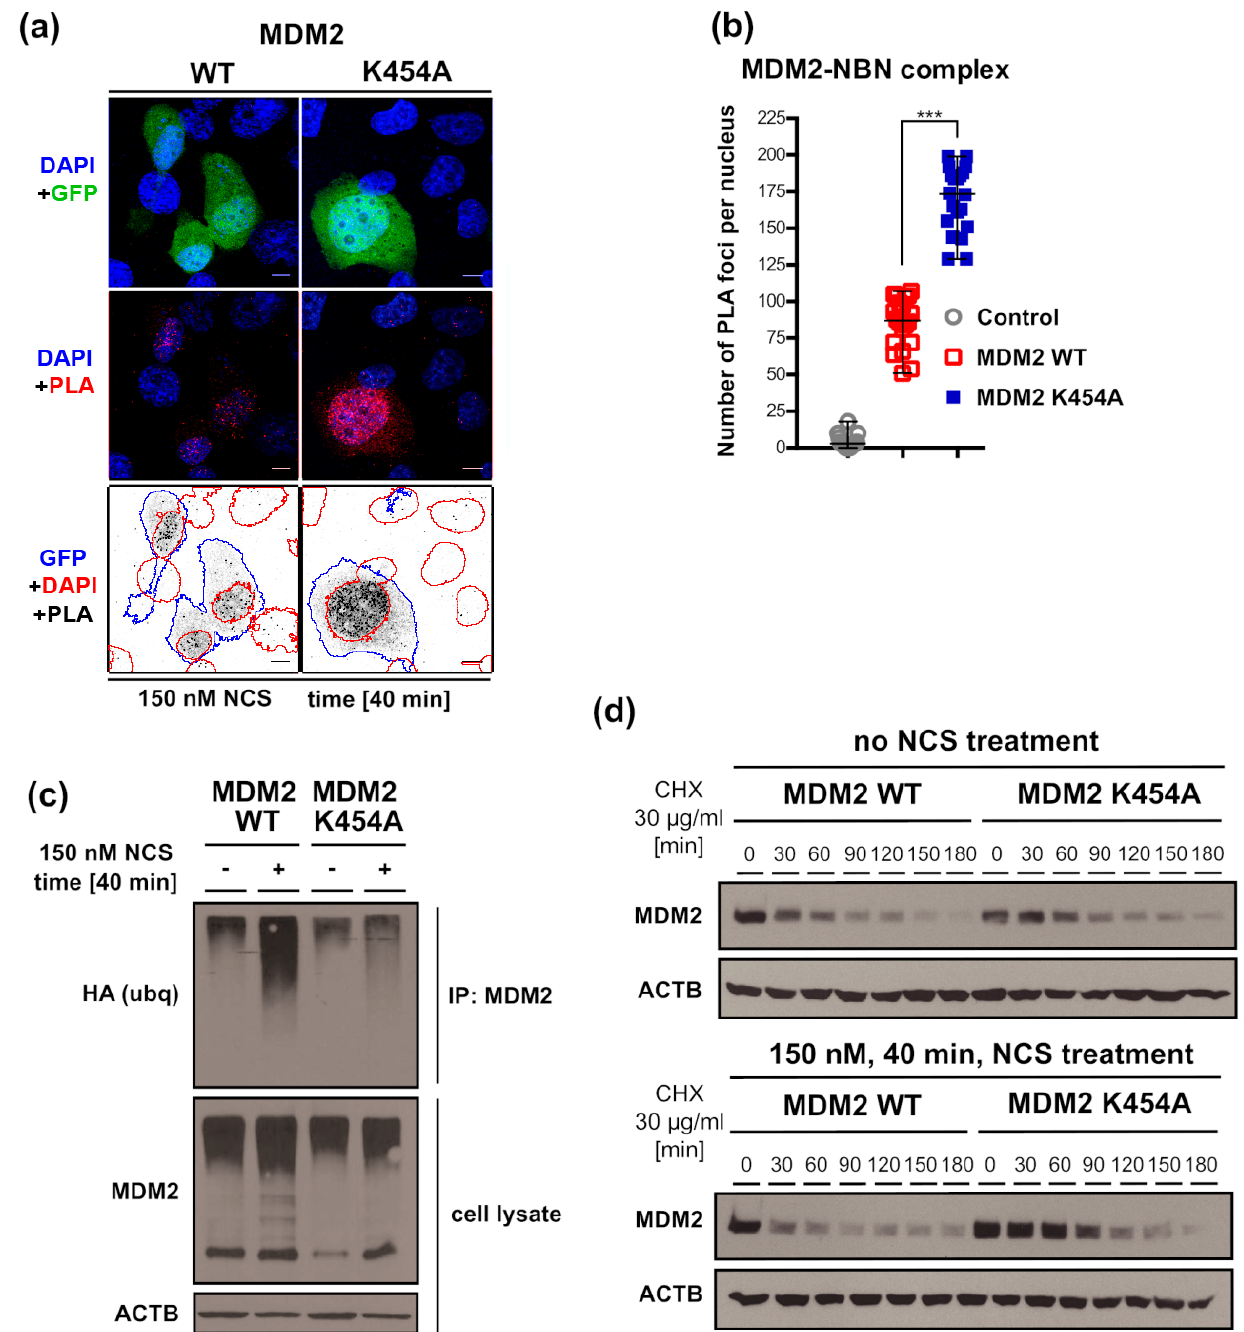
Figure 7. Analysis of NBN–MDM2 interaction efficiency and MDM2 stability after NCS treatment. ( a ) Proximity ligation assay between MDM2 and NBN, performed at 40 min after 150 nM NCS treatment. Representative fields of view shown for MDM2 WT and K454A transfections. GFP is a co-transfection marker for MDM2 expression. Red fluorescence (PLA) represents direct proximity of MDM2 and NBN. In the bottom panel, the PLA signal is represented by black dots, and the location of nuclei is marked by red outlines and GFP by blue outlines. GFP-positive cells are also MDM2-overexpressing cells. ( b ) Quantification of PLA foci number per nucleus . Statistical significance was assessed by comparing overexpres- sion of MDM2 WT and K454A, *** p < 0.001. Control transfection with GFP plasmid. ( c ) In-vivo protein ubiquitination